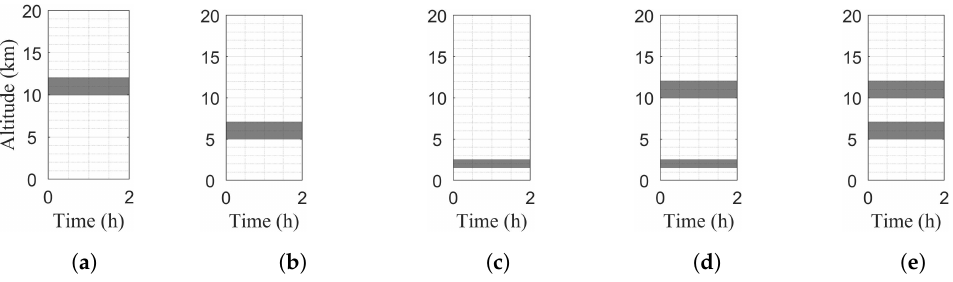
Figure 8. Prototypes of cloud vertical structure specified in simulations, ( a ) HC, ( b ) MC, ( c ) LC, ( d ) HC + LC and ( e ) HC +